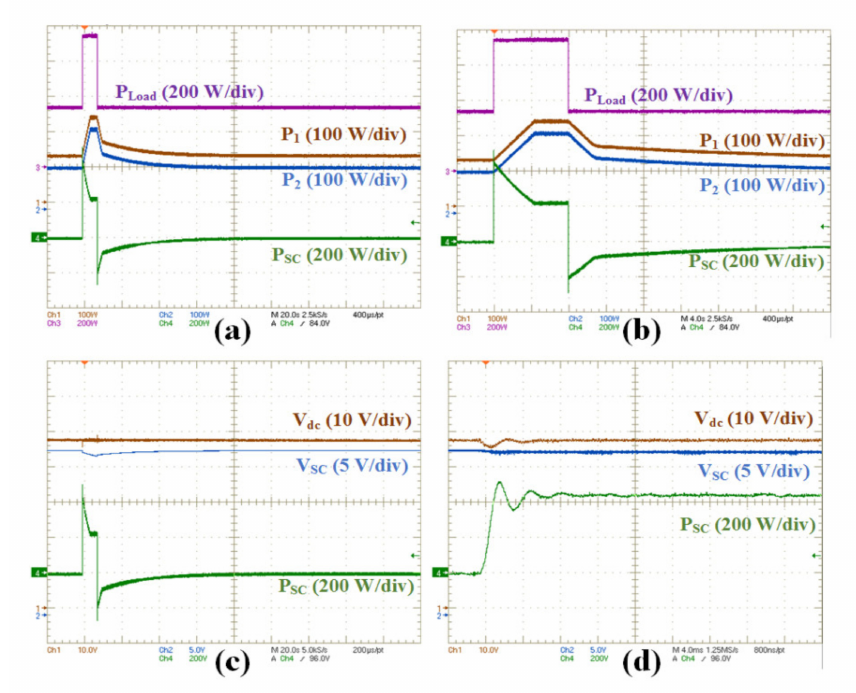
Figure 19. Experimental result of the energy management system when the stacks are in the normal condition and an overload occurs: ( a ) Injected power and load power variations; ( b ) Zoom on powers; ( c ) DC link and SC voltage changes; ( d ) zoom on the part